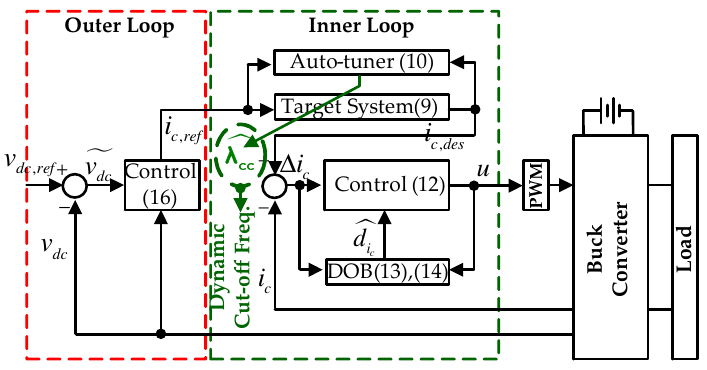
Figure 3. Proposed structure of cascade-type control